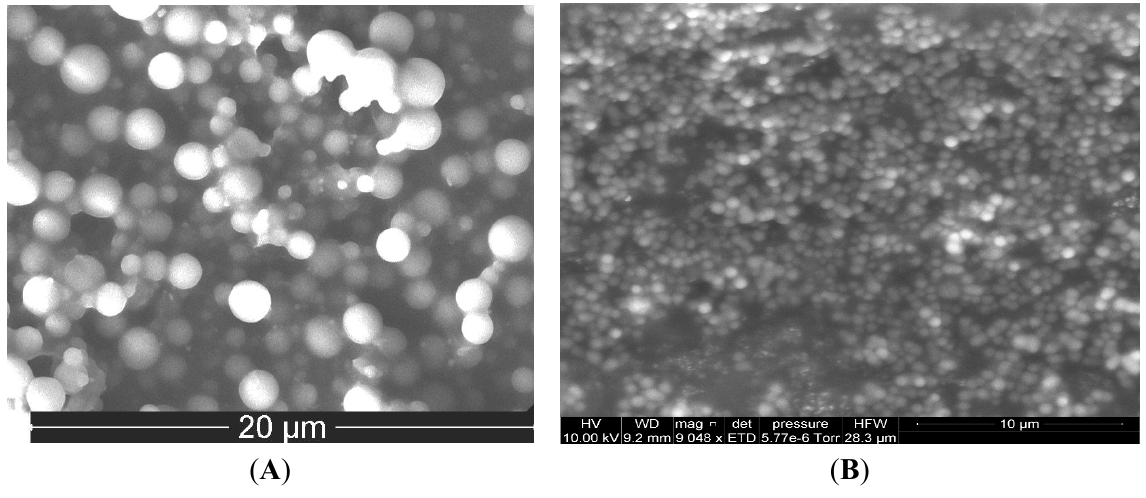
Figure 1. Typical SEM images of blank nanoparticles prepared by in situ dispersion polymerization ( A ) Poly- L -lactide-based nanoparticles; ( B ) Poly- ε -caprolactone-based nanoparticles. Table 1. Composition and response of D -optimal mixture experiemntal design for the fabrication of stealth poly- L -lactide-based